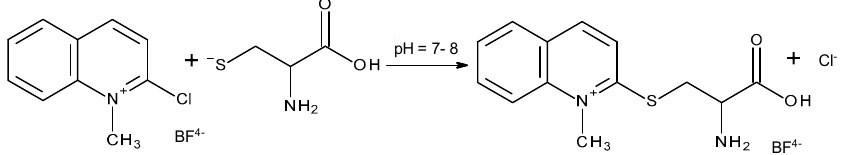
Figure 5. The scheme of the derivatization reaction of cysteine with the use of 2-chloro-1- methylquinolinium tetrafluoroborate.